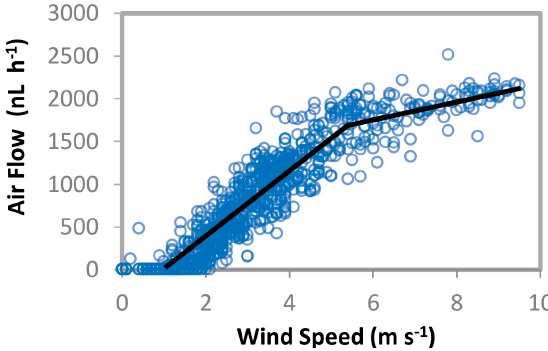
Figure 3. Relationship of wind speed and air flow generated by the wind ‐ driven pump during the open end measurement (the pressure loss within the aeration system itself was neglected). The black line indicates the two ‐ step segmented linear regression with the breakpoint at a wind speed of approximately 5.4 m ∙ s − 1 ( R 2 = 0.88).